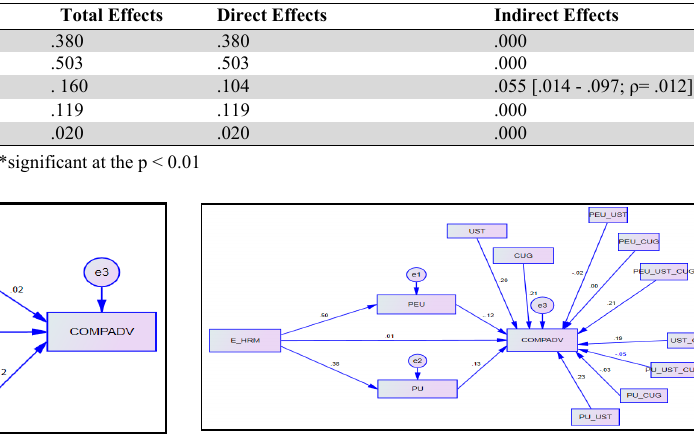
Fig. 3. Mediation Effects Analysis Fig. 3. Mediated-Moderated Analyses of the research model